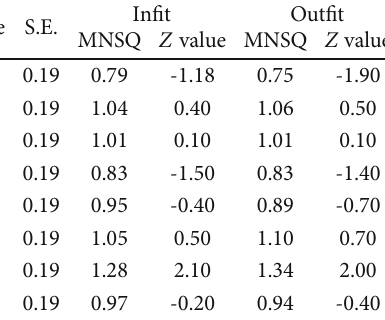
Table 1: Item fi t statistics: entry order.